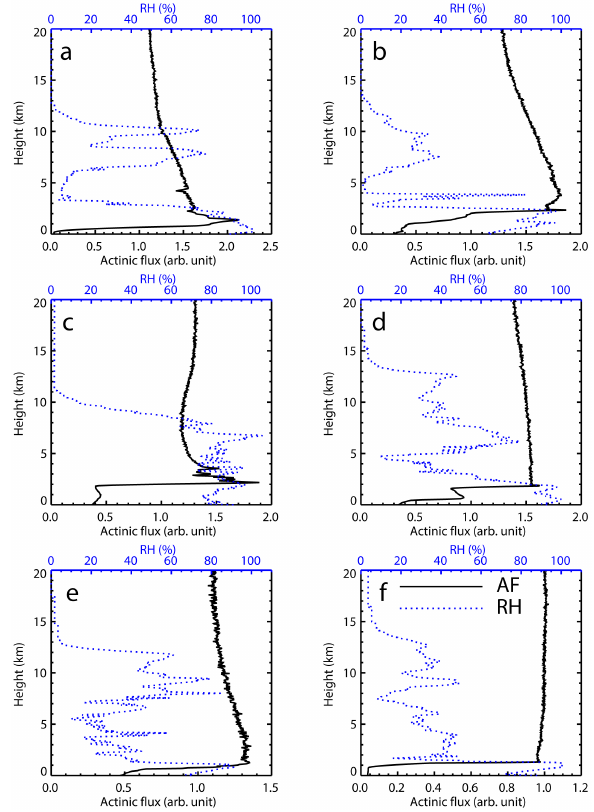
Figure 5. Actinic flux (AF) and relative humidity (RH) profiles for cloudy scenes measured on (a) 15 June 2006, SZA = 28.8 ◦ , (b) 22 June 2006, SZA = 28.7 ◦ , (c) 10 August 2006, SZA = 36.7 ◦ , (d) 5 September 2006, SZA = 45.4 ◦ , (e) 6 September 2006, SZA = 45.7 ◦ , and (f) 21 December 2006, SZA = 75.6 ◦ . The profiles are ascending measurements and are not normalized. The SZA value is at 11:30 UTC, the start of the profile.